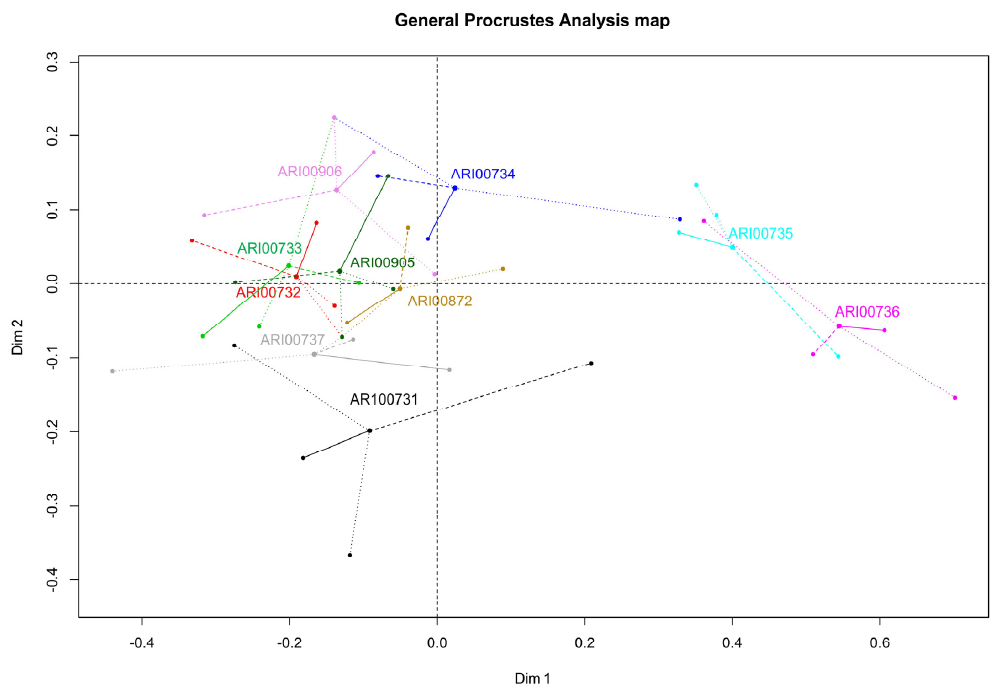
Figure 7. Two-dimensional plot inferred from the combined generalized Procrustes